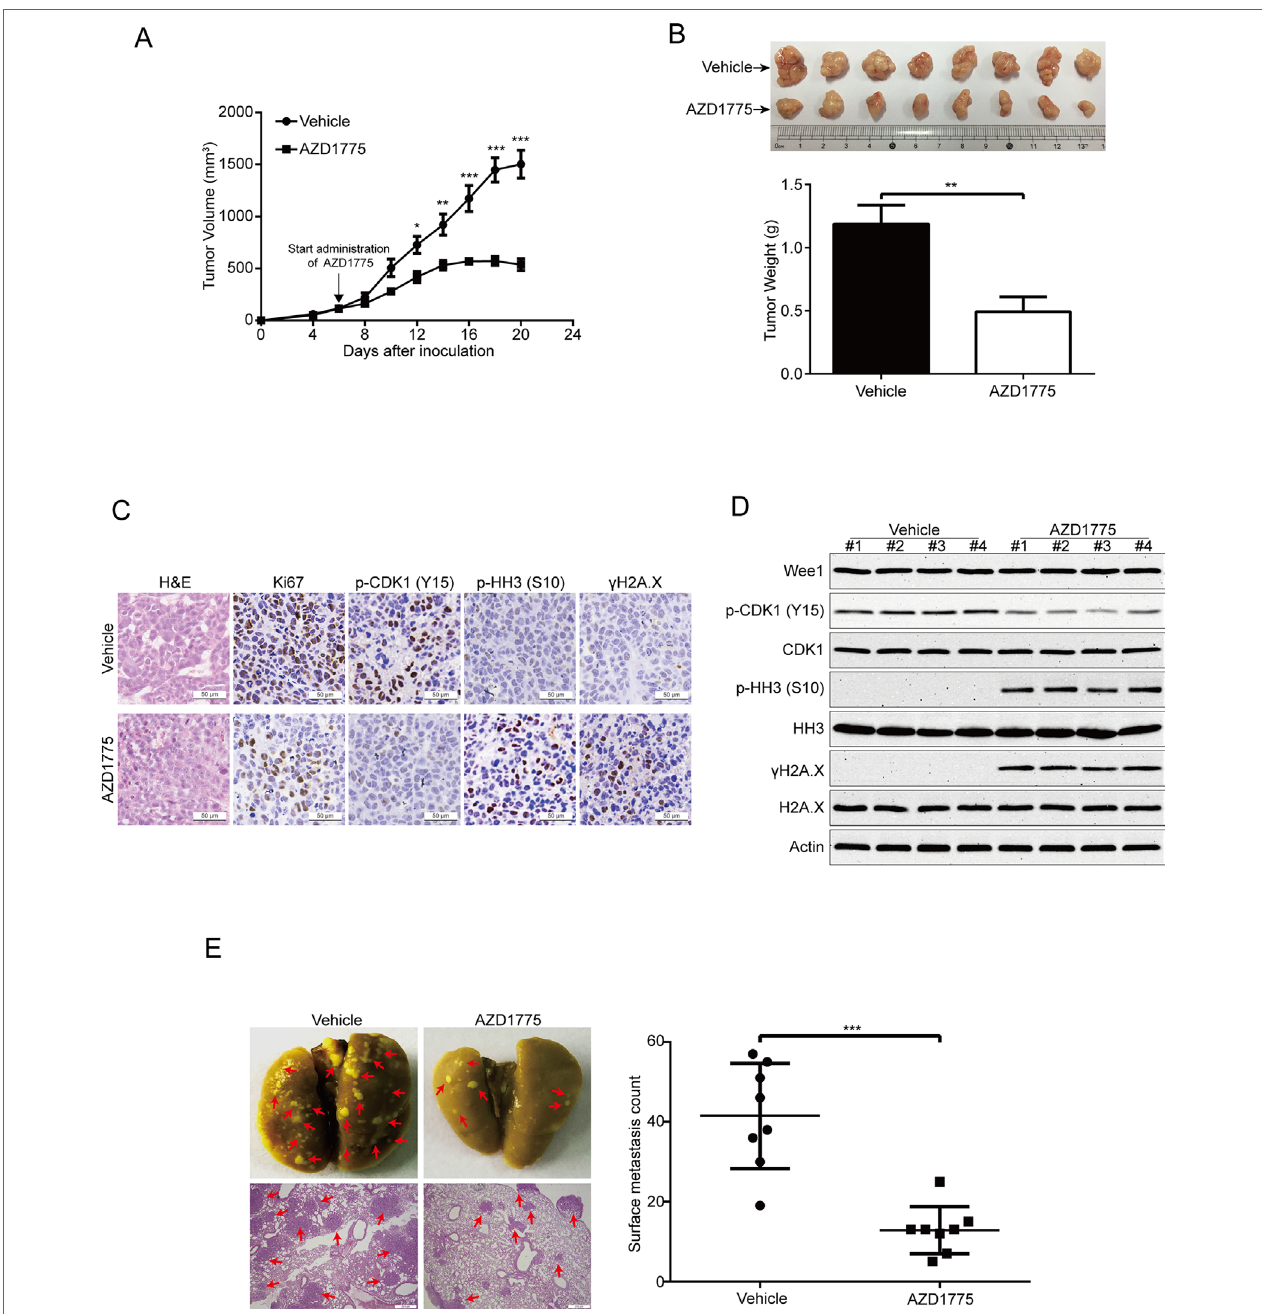
FIGURE 7 | AZD1775 inhibits ESCC cell growth and metastasis in nude mice. (A) Nude mice bearing KYSE150 xenograft tumors were treated with vehicle (0.5% methylcellulose) or AZD1775 (60 mg/kg, treated by oral gavage daily) from day 6 to 20 after inoculation of KYSE150 cells. The tumor growth curves were shown. Point, mean; error bar, SD. n = 8 per group. (B) After 14 days of AZD1775 treatment, the mice were killed, and tumors were dissected, weighed, and photographed. Top: Representative tumors from the control and experimental group are shown; Bottom: Comparison of tumor weights in control and AZD1775 treated group ( n = 8 per group). (C) H&E staining and IHC analysis of Ki67, phospho-CDK1 (p-CDK1 Y15 ), phospho- histone H3 (p-HH3 S10 ) and γ H2A.X in xenograft tissues from mice. Scale bar: 50 μm. (D) Immunoblotting of the Wee1, p-HH3 S10 , HH3, p-CDK1 Y15 , CDK1, γ H2A.X, and H2A.X proteins in xenograft tissues was shown. (E) KYSE150 cells were intravenously injected into nude mice via the lateral tail vein. Left: Representative images of lungs (upper panel) and lung sections stained with H&E (lower panel) harvested 8 weeks postinjection (arrows indicate the metastatic nodules). Right: Surface metastatic nodules in the lungs were counted. Data represent mean ± SD ( n = 8 per group). Scale bar, 200 μm. * P < 0.05, ** P < 0.01, *** P < 0.001, by Student’s t